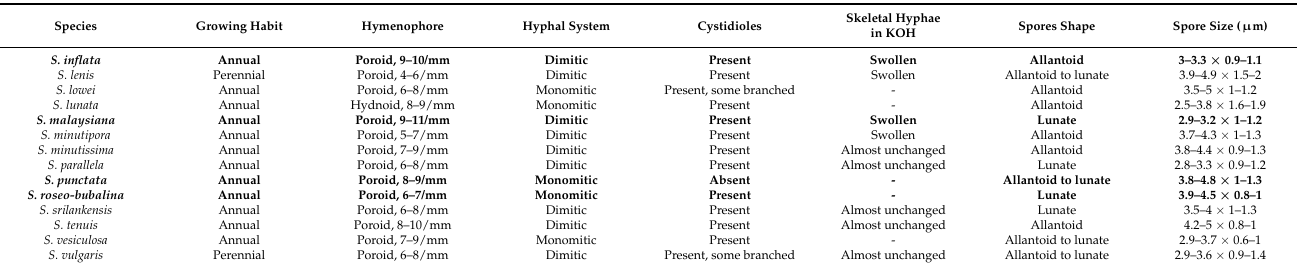
Table 1. The main characteristics of Sidera species. Pore and basidiospore sizes partly from Du et al. (2020) [2], Rajchenberg (1987) [4], Du et al. (2019) [7], Niemelä and Dai (1997) [8] and Niemelä (2005)